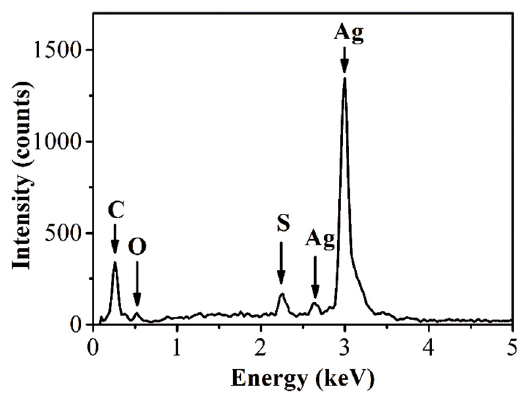
Figure 4: EDX spectrum of CA-RGO-Ag-6.